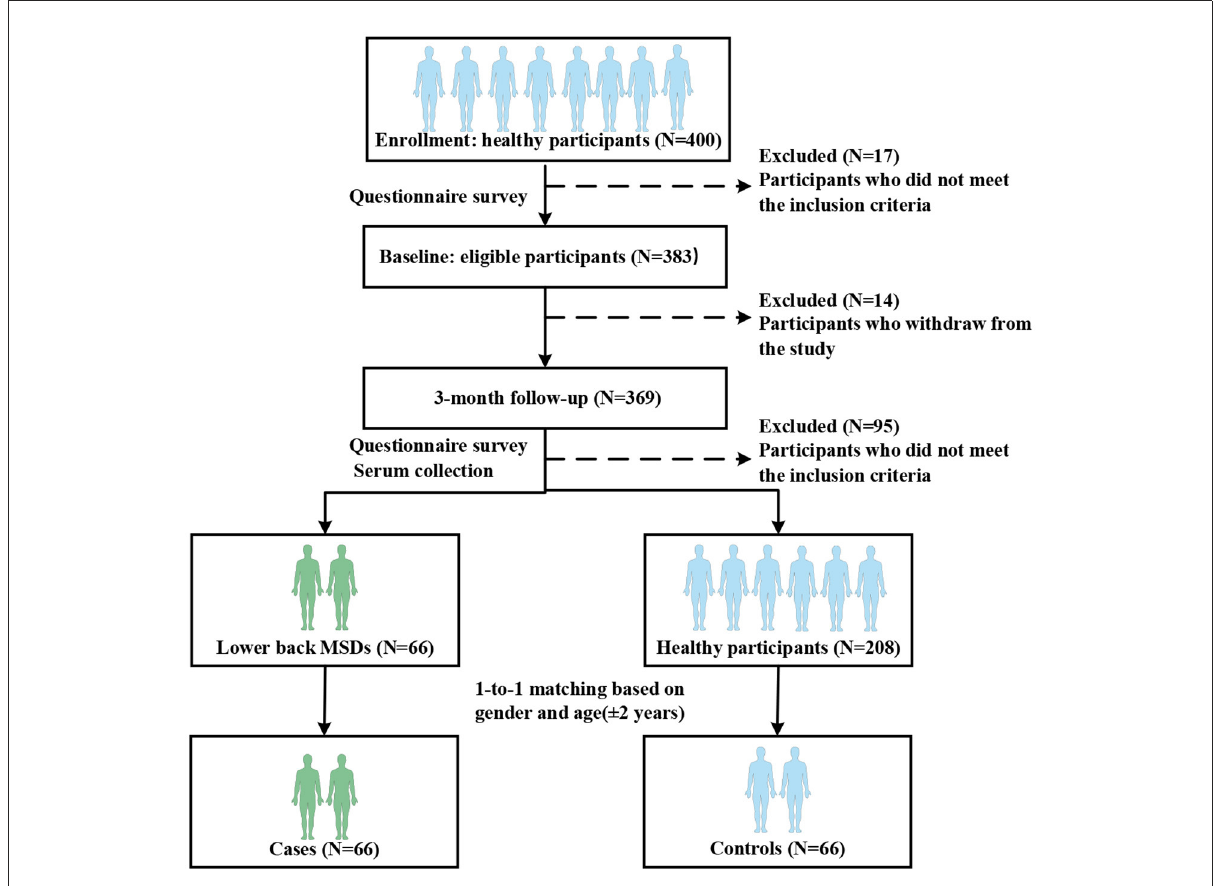
FIGURE1 Flow chart of the nested case-control